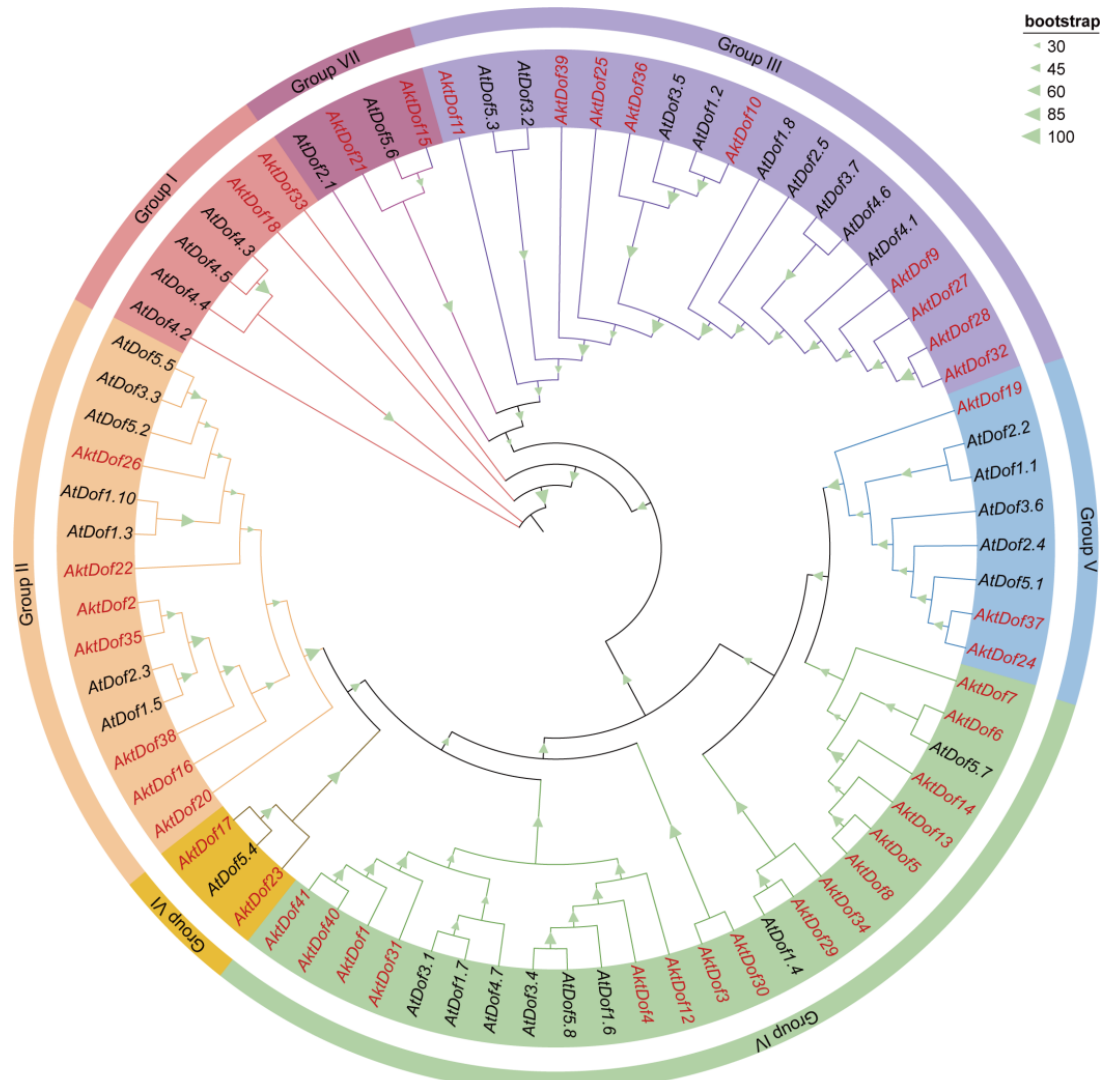
Figure 1. Phylogenetic tree of Dof families in A. trifoliata and Arabidopsis . Phylogenetic trees were constructed from 77 Dof proteins from A. trifoliata (41) and Arabidopsis (36) using the ML method and 1000 bootstrap replicate. Different branch colors and background colors represent seven groups. AktDofs is indicated in red, AtDofs in black, the bootstrap program is displayed in the green triangle on the branch.